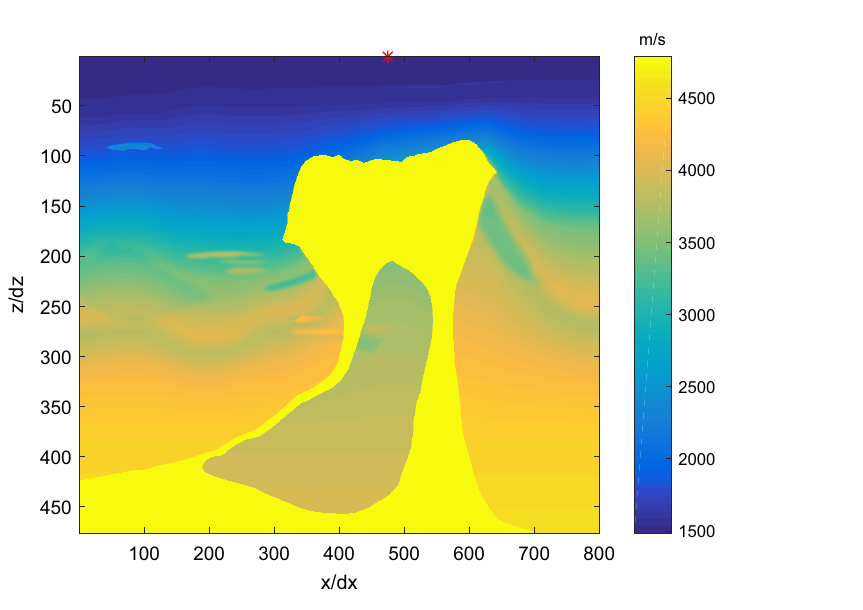
Figure 4. The BP salt velocity